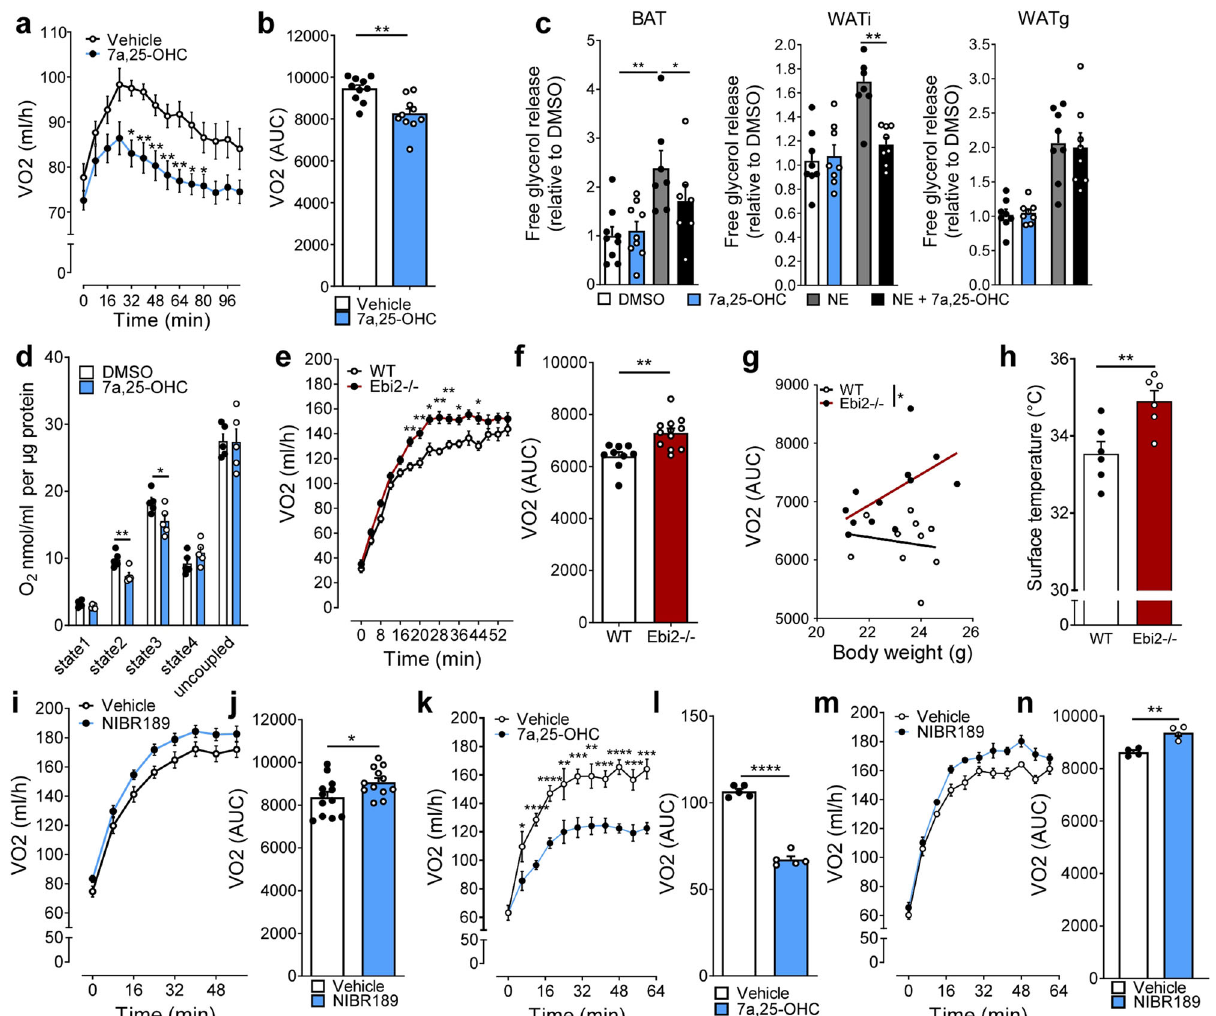
Fig. 4 EBI2-mediated regulation of energy expenditure in vivo. a , b Energy expenditure (VO2) following injection of 7 α ,25-OHC (5 mg/kg i.p.) or vehicle ( n = 10 mice per condition). c Relative lipolysis in ATs (pups BAT, left; adult WATi, middle; adult WATg, right) treated with NE (1 µ M) and 7a,25-OHC (1 µ M) ( n = 8 independent explants per condition). d Ex vivo oxygen respiration of BAT treated with vehicle or 7 α ,25-OHC (1 µ M) ( n = 5 independent samples). e , f Energy expenditure (VO2) of WT and EBI2 − / − mice during 1 h of cold exposure (4 °C) ( n = 10 WT and n = 12 Ebi2 − / − ). g ANCOVA analysis of energy expenditure and body weight of WT and EBI2 − / − mice during 1 h of cold exposure ( n = 10 WT and n = 12 Ebi2 − / − ). h Infrared thermography of WT and EBI2 − / − newborn mice at 23 °C ( n = 6 pups per genotype). i, j Energy expenditure (VO2) of mice treated with vehicle or EBI2 antagonist NIBR189 during 1 h at 4 °C ( n = 12 animals per condition). k , l Energy expenditure (VO2) over 1 h at 16 °C of mice injected with vehicle or 7 α